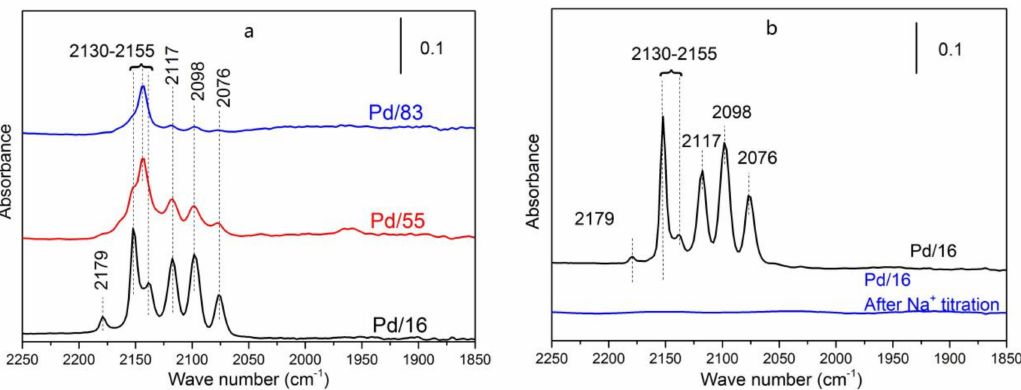
Figure 5. In situ FT-IR of CO adsorption (temperature: 80 ◦ C; flow: CO (1000 ppm) + N 2 ; ( a ): spectra of Pd/16, Pd/55, and Pd/83; ( b ): the spectrum of Pd/16 treated by Na +